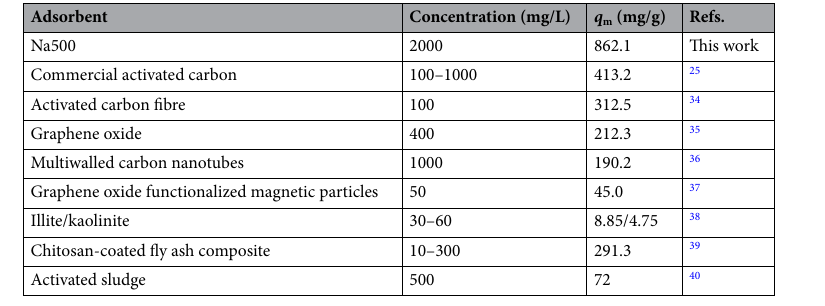
Table 4. Comparison of adsorption capability of OTC on Na500 with other adsorbents.